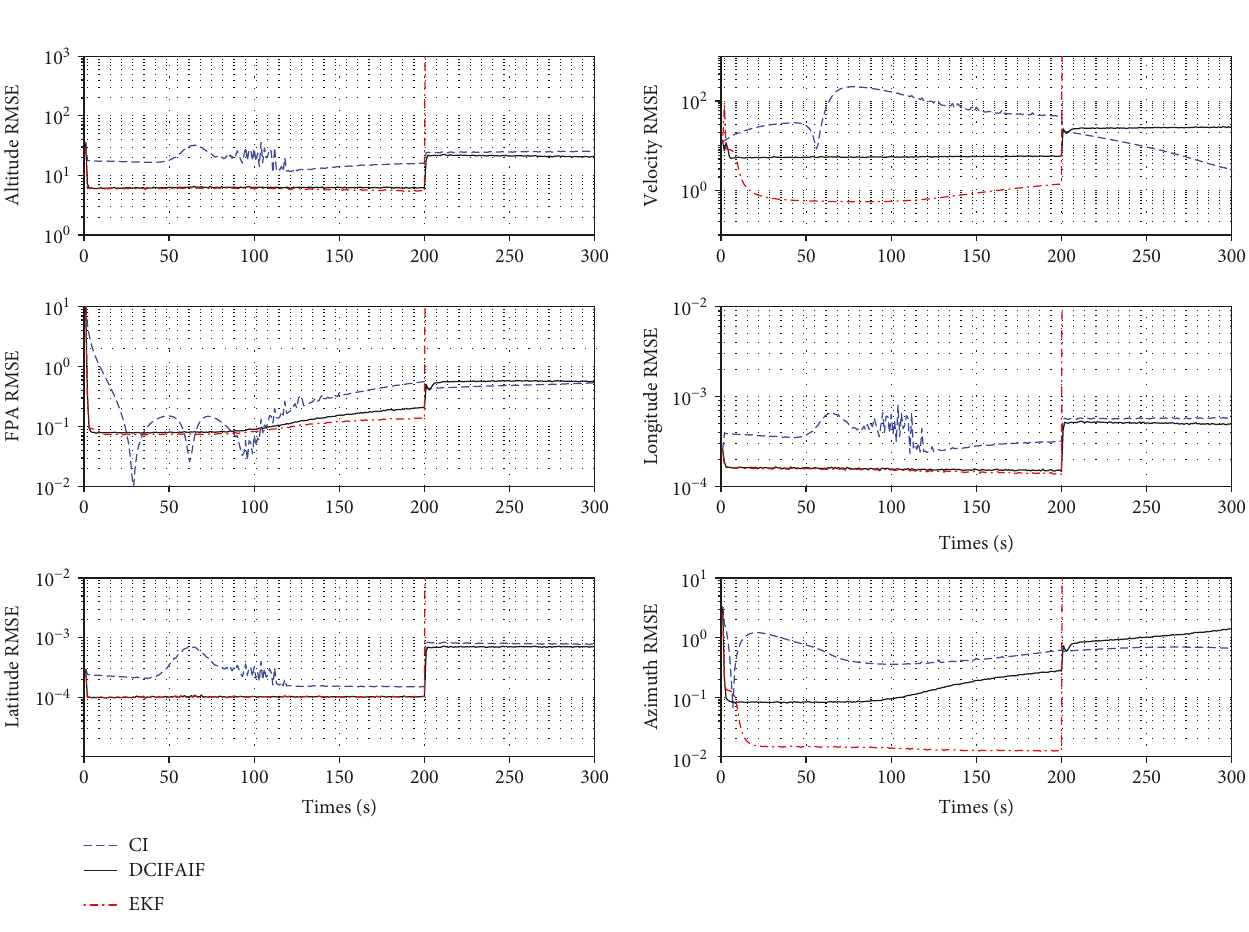
Figure 10: RMSEs for three methods when faults occur during Mars